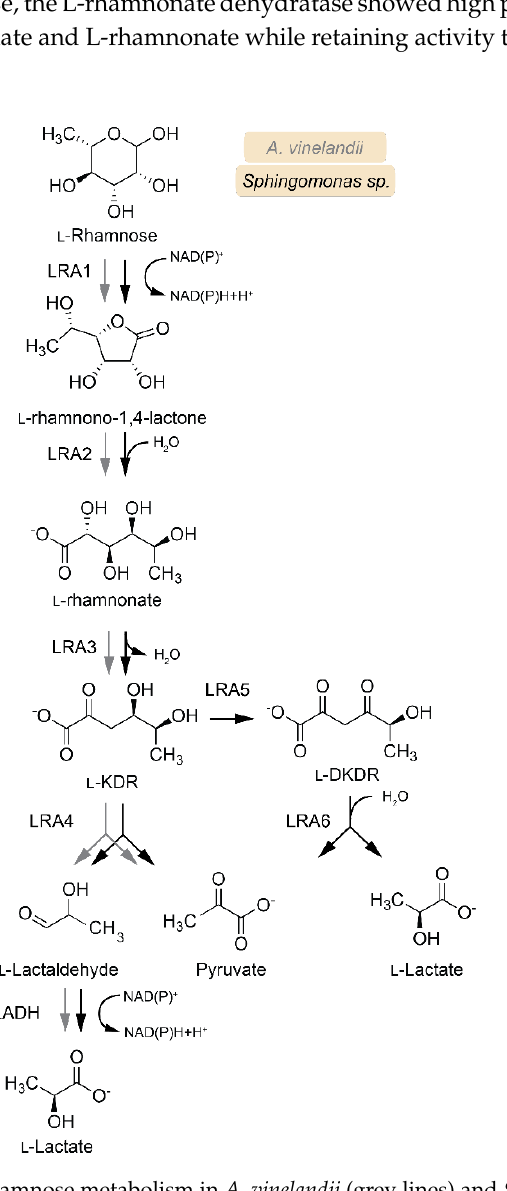
Figure 3. Overview of L -rhamnose metabolism in A. vinelandii (grey lines) and Sphingomonas sp. (black lines). LRA1: L -rhamnose-1-dehydrogenase, LRA2: L -rhamnono-lactonase, LRA3: L -rhamnonate